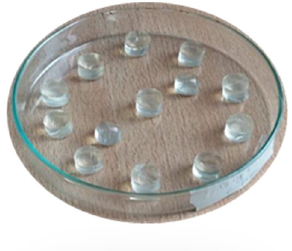
Figure 1. Developed Na-CMC-g-poly (MAA) hydrogel discs.